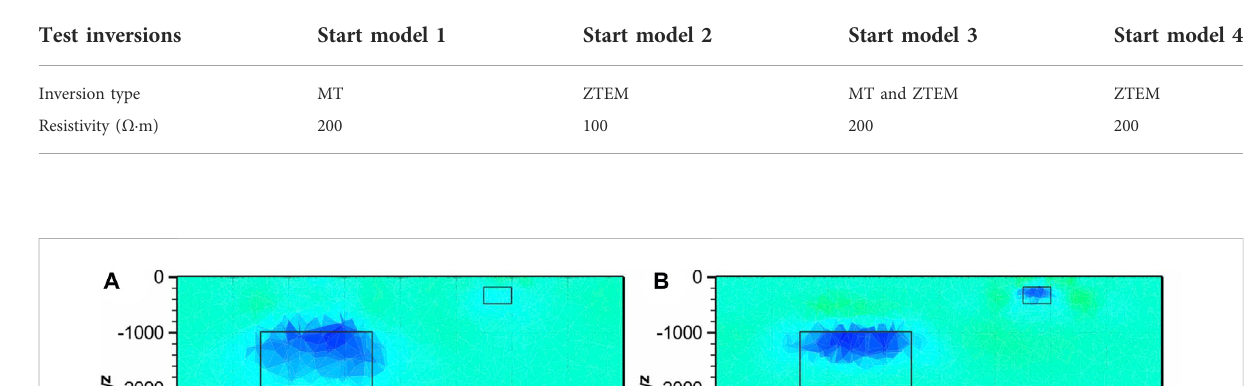
TABLE 2 Initial model settings.